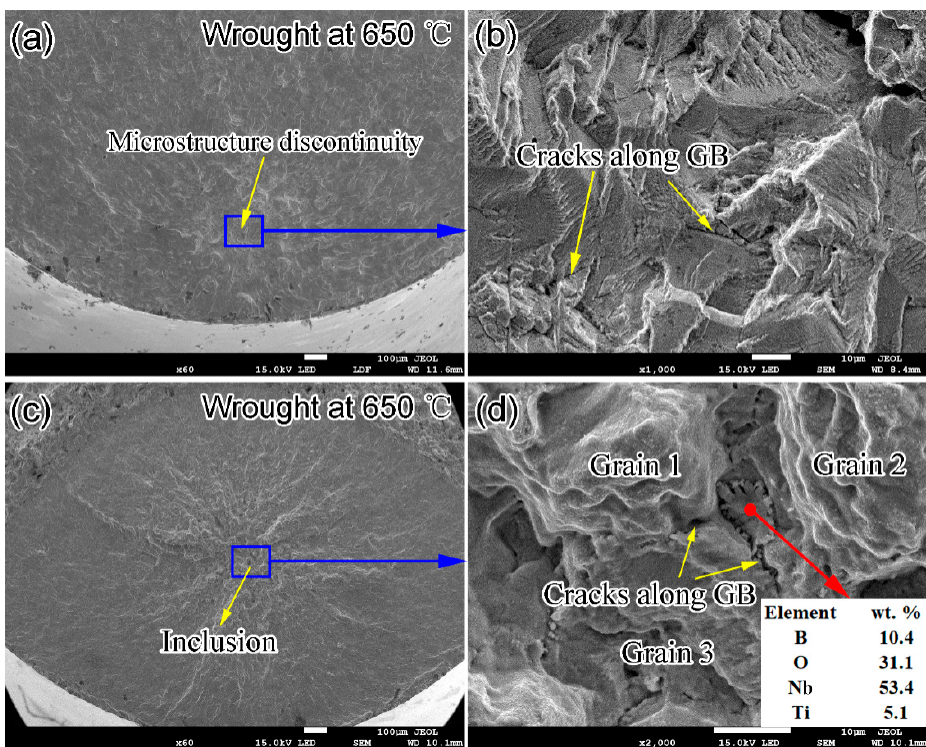
Figure 8. Representative SEM fractographic images of wrought IN718 specimens tested at 650 °C: ( a , b ) σ a = 457MPa, N f = 2.2 × 10 8 ; ( c , d ) σ a = 440 MPa, Nf = 4.5 × 10 8 .